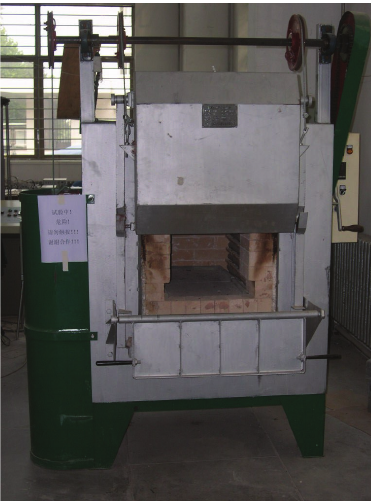
Figure 1: Box-type electric furnace.